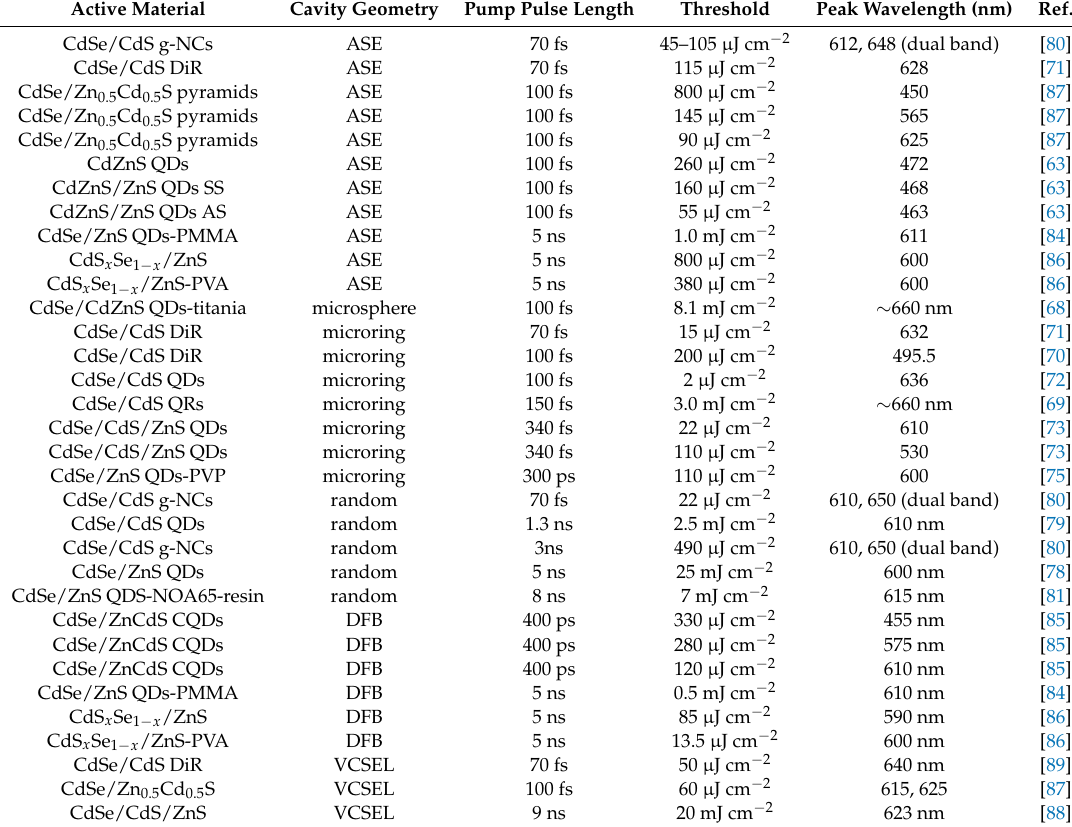
Table 1. Amplified Spontaneous Emission and lasing properties of light amplifying active materials based on nanocrystals (NCs) and polyer-NCs hybrids. The data are ordered taking into account the cavity type and in order of increasing pump pulse time